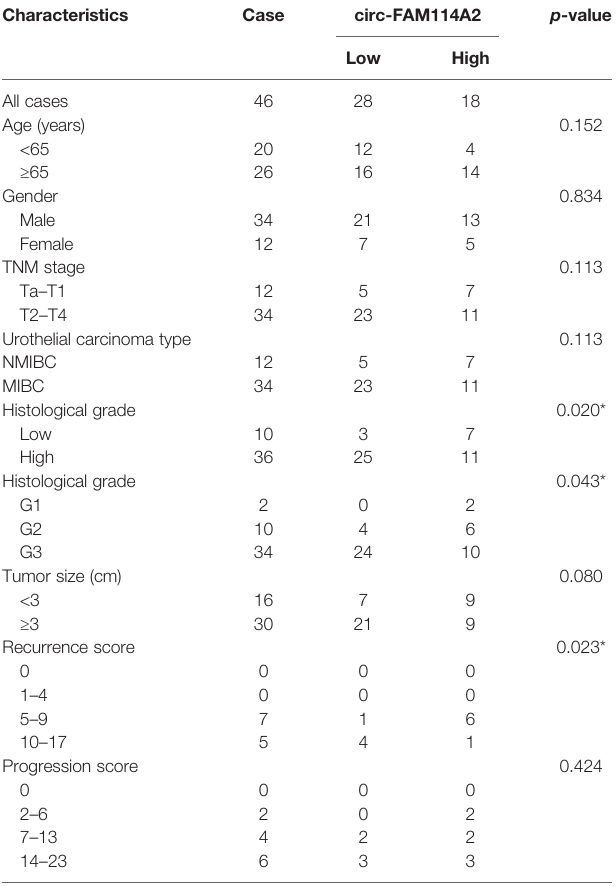
TABLE 1 | Correlations between the expression of circFAM114A2 and clinicopathological features in urothelial carcinoma patients.